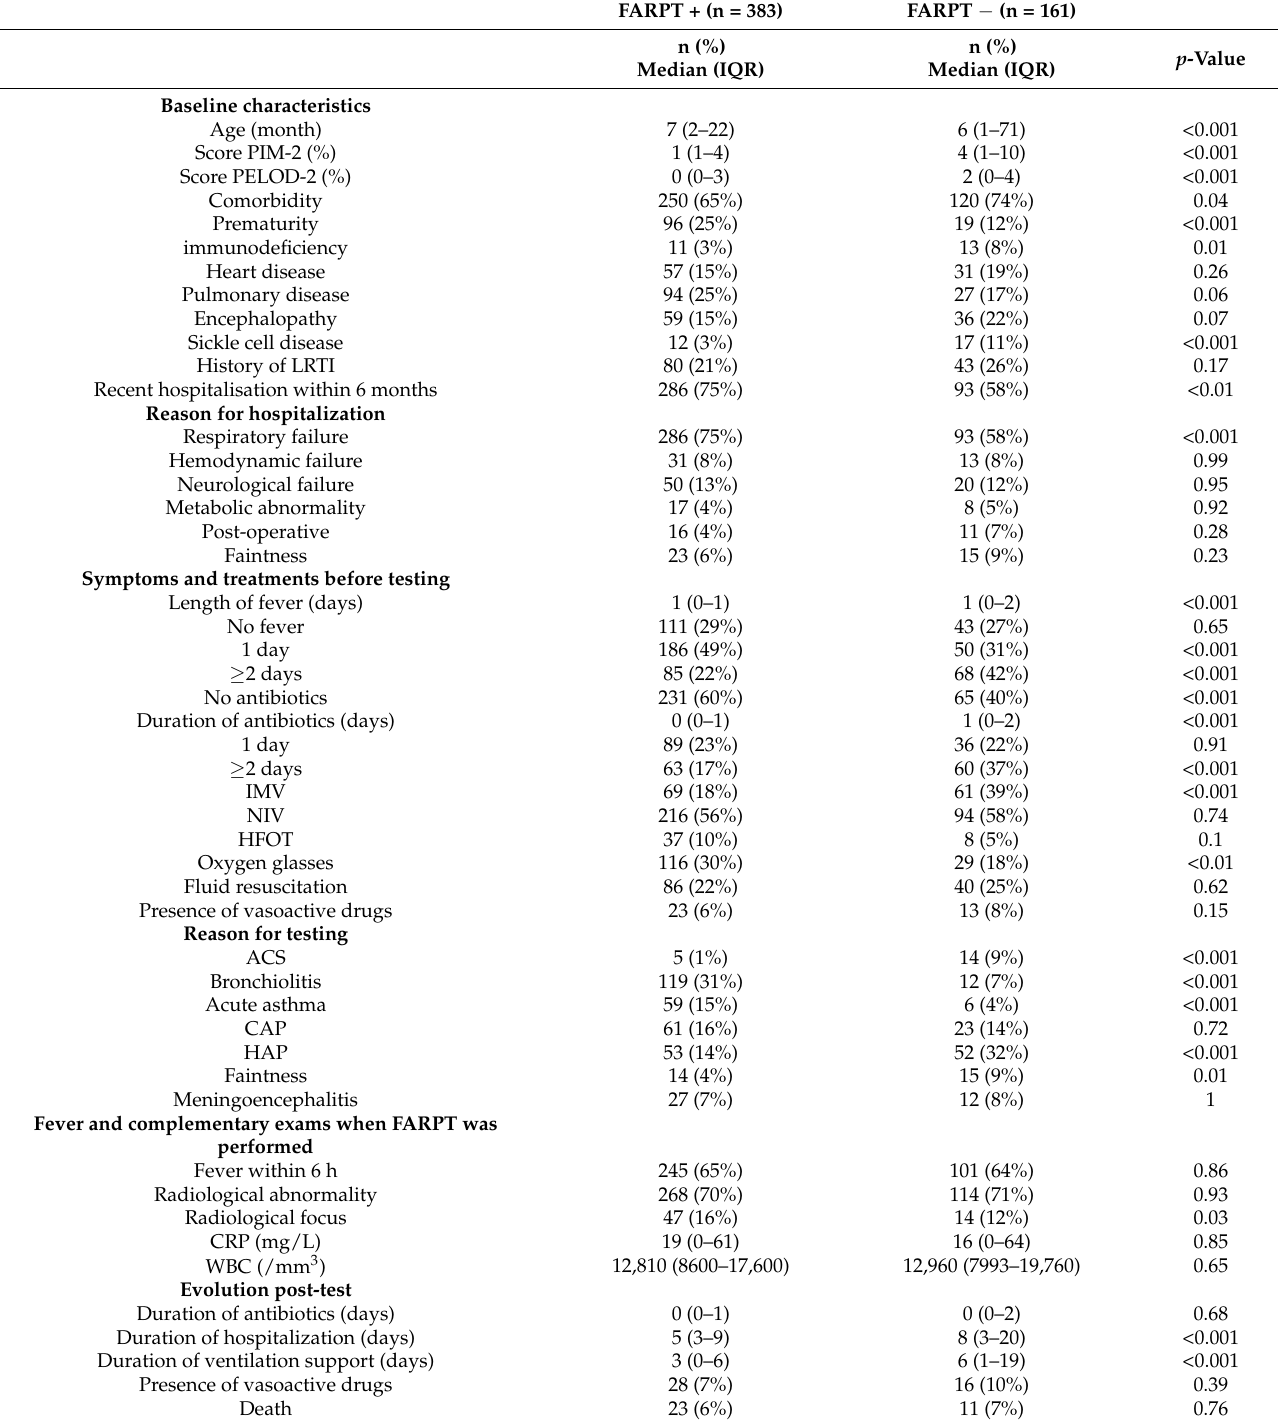
Table 2. Patient’s characteristics according to FilmArray ® Respiratory Panel test